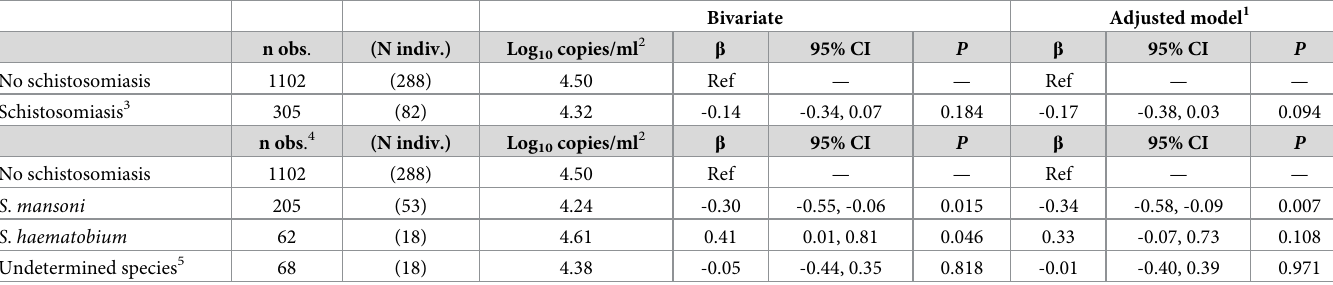
Table 2. Associations between schistosomiasis and HIV-1 set point plasma viral